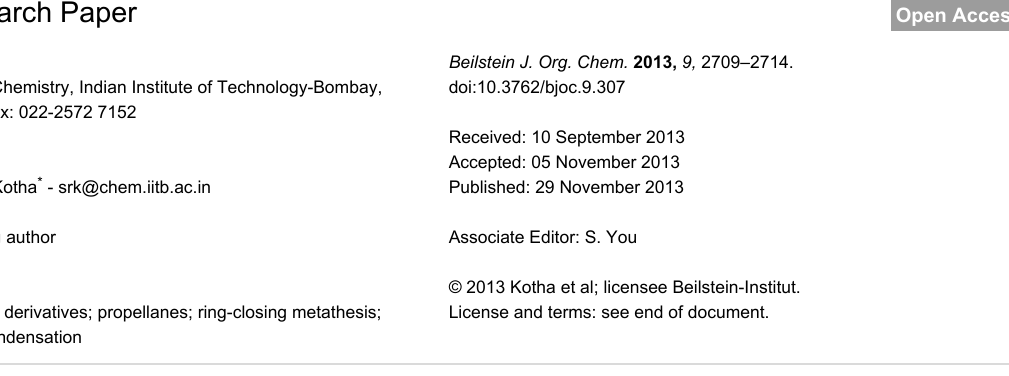
dine C [22], and lundurine B exhibit multidrug resistance (MDR) in vincristine-resistant KB cancer cells [23,24]. Minfiensine alkaloid [25-31] containing a novel 1,2,3,4-tetrahy- drocarbazole ring skeleton shows anticancer activity